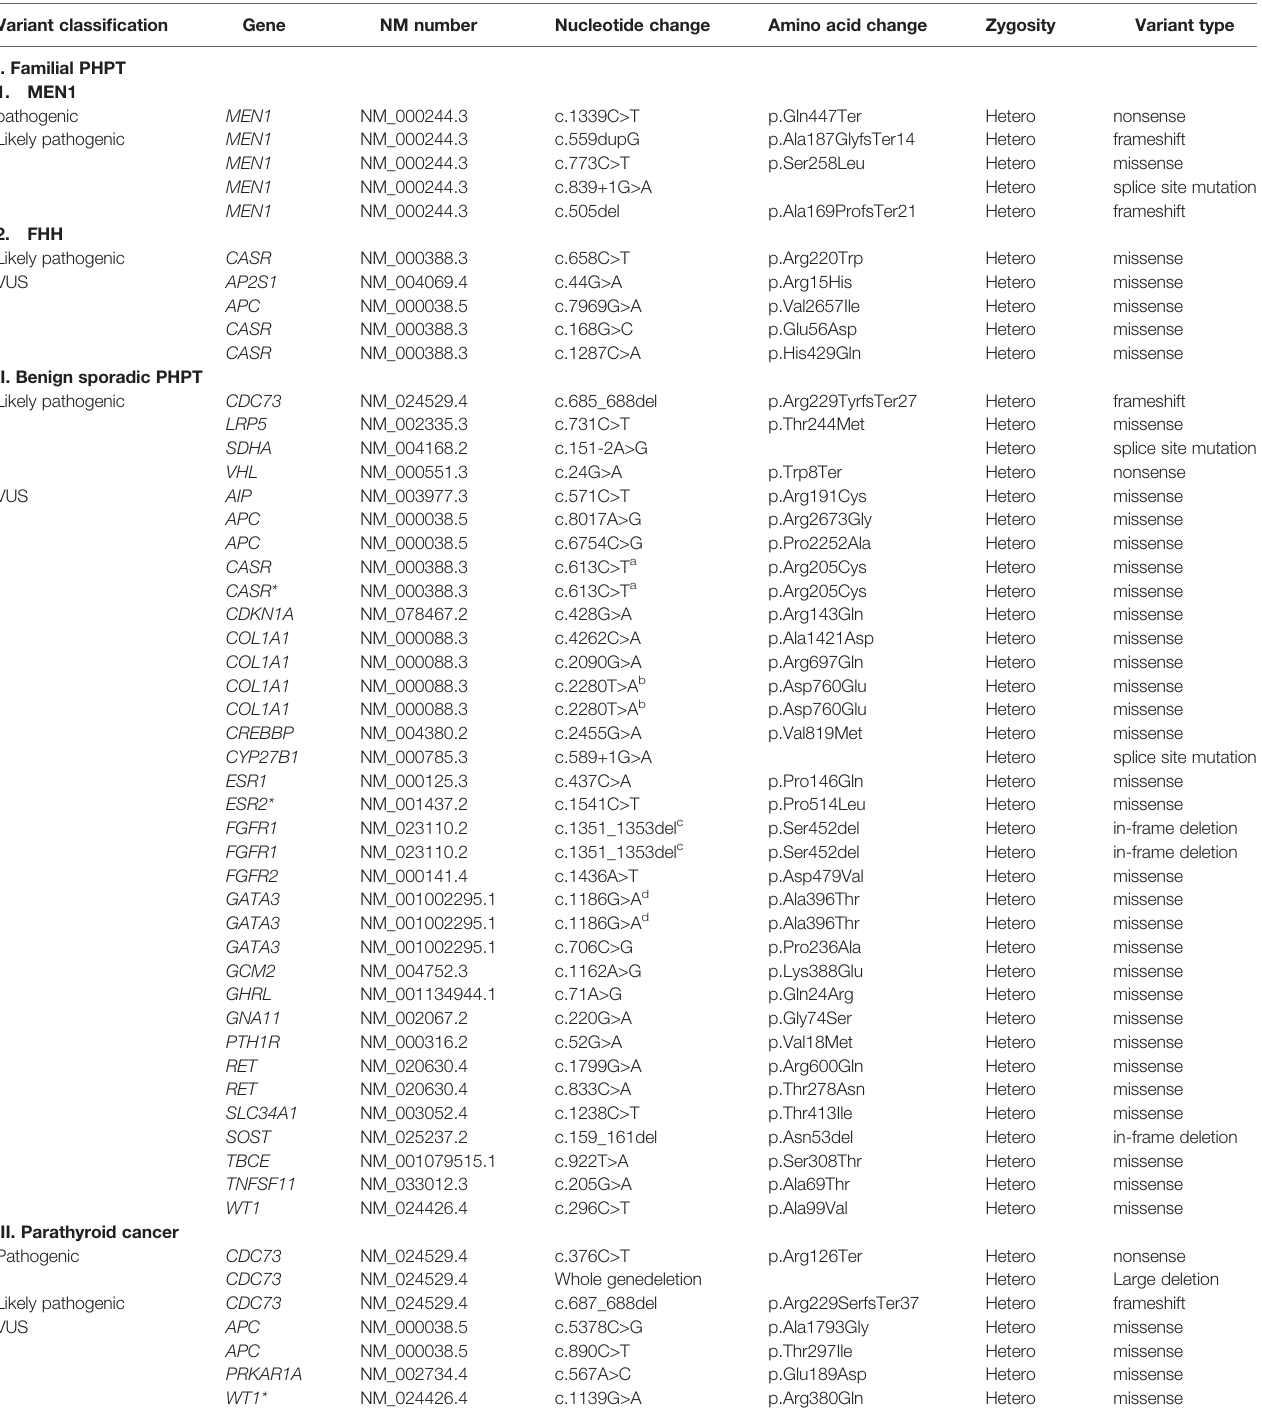
TABLE 2 | Genetic variants identi fi ed by next-generation